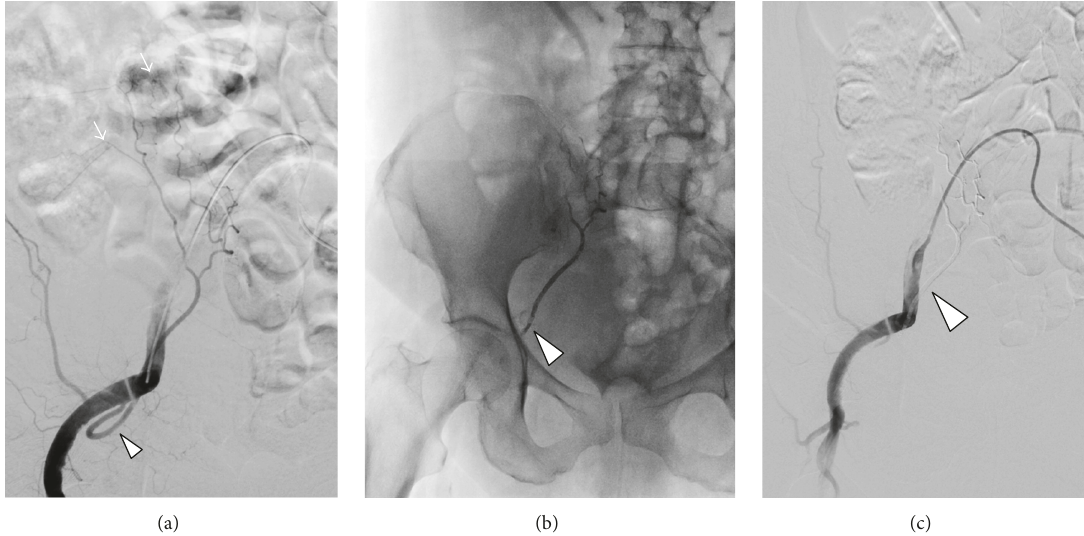
Figure 2: (a) Selective right iliac angiography confirmed the two spots of active bleeding (arrows) from distal collaterals of the right epigastric artery (arrowhead). (b) Fluoroscopic control with the right epigastric artery (arrowhead) filled by Squidperi 18 liquid embolic material. (c) Final selective right iliac angiography that confirms the embolization of the right epigastric artery (arrowhead) filled by Squidperi 18 liquid embolic material as a grey shadow.